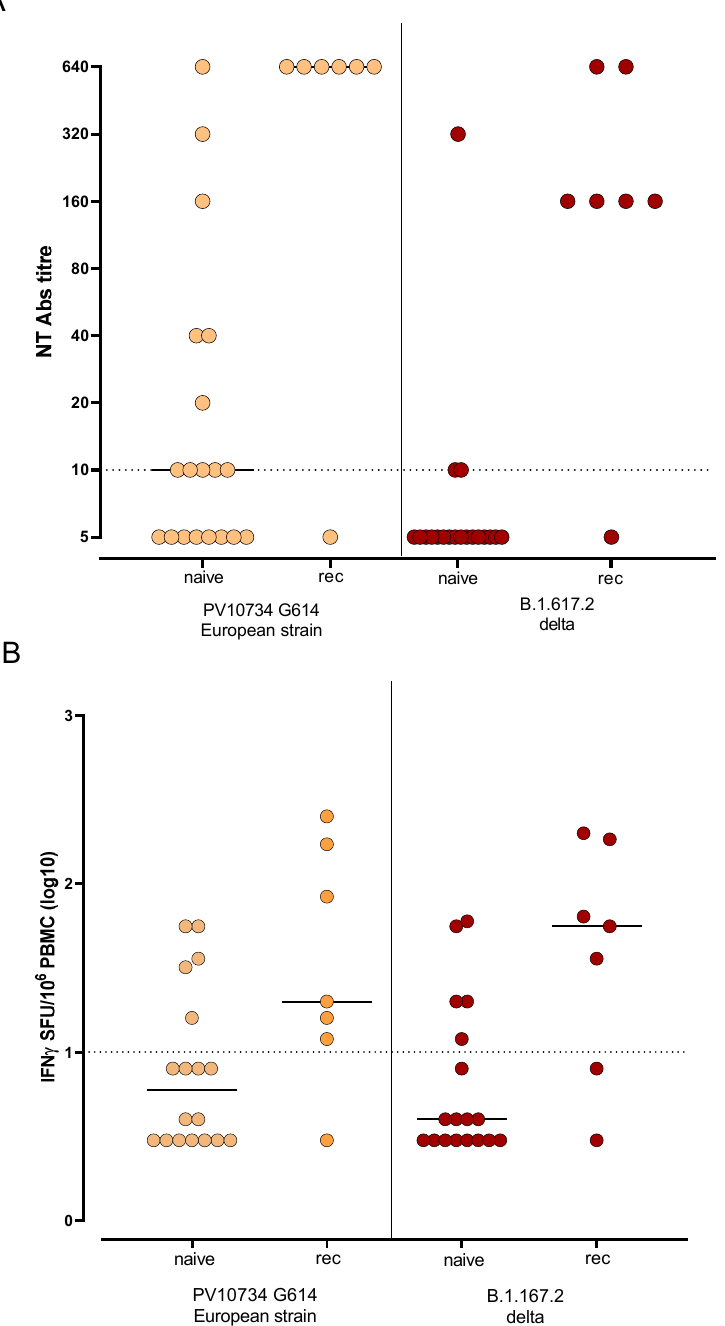
Figure 3. SARS-CoV-2 NT Abs ( A ) and T-cell response ( B ) against reference SARS-CoV-2 strain (PV10734 G614 European strain) and delta variant (B.1.167.2) were tested in 19 naïve and 7 recovered (rec) SOTRs. Median level is shown for each